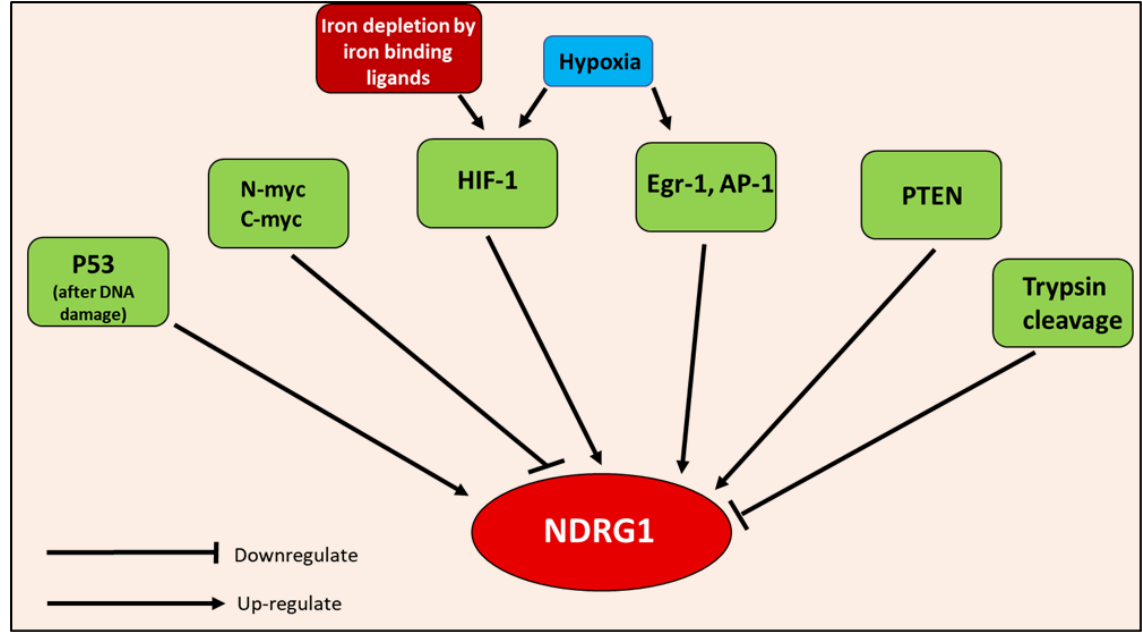
Figure 8. Inducers of NDRG1, including: HIF-1, Egr-1, AP-1, PTEN, p53, hypoxia, iron depletion, and inhibitors of NDRG1, including N-myc, c-myc, and trypsin cleavage.